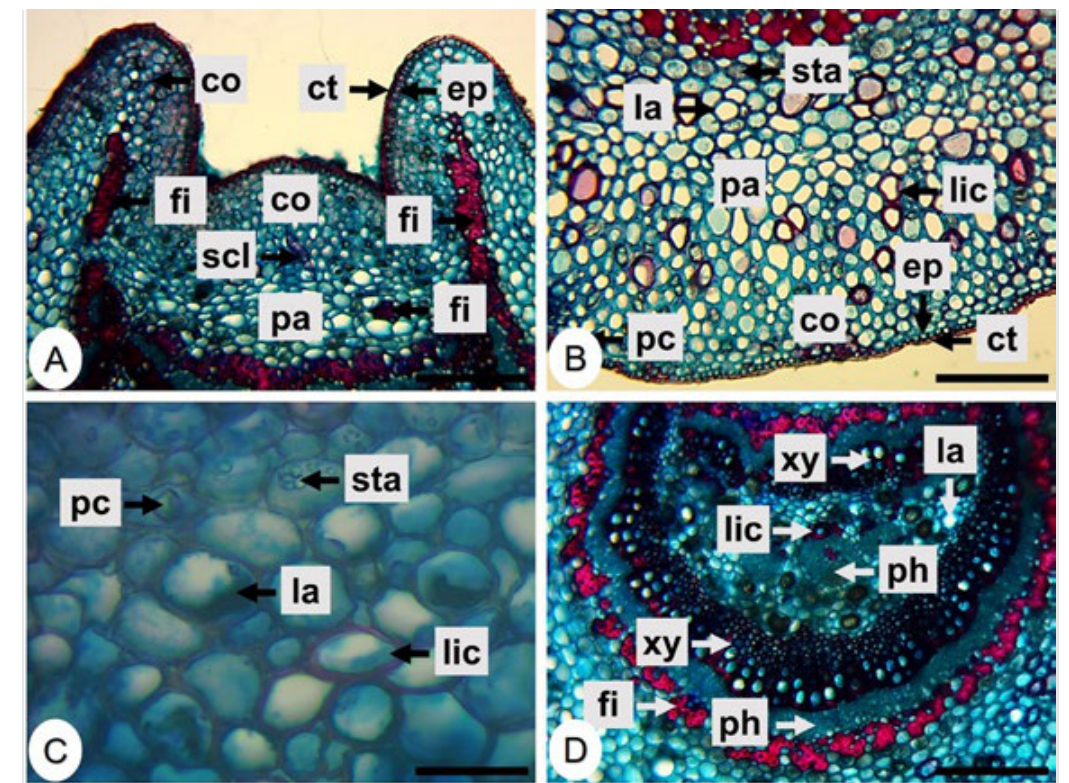
FIGURE 2 - Cross-sections of the petiole of Manilkara zapota (L.) P.Royen (Sapotaceae). A, B, C: general organization of the structures. D: detail of the cortical region. Abbreviations: co = collenchyma; ct = cuticle; ep = epidermis; fi = fiber; la = laticifer; lic = lignified cell; pa = parenchyma; pc = prismatic crystal; ph = phloem; scl = sclereid; sta = starch; xy = xylem. Bars: A, B, D = 200 µm; C = 50 µm.